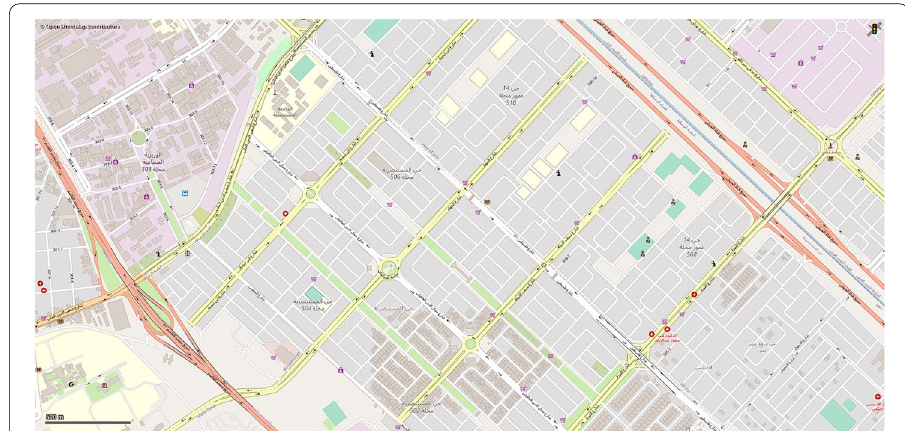
Fig. 1 Open street map of Palestine arterial street